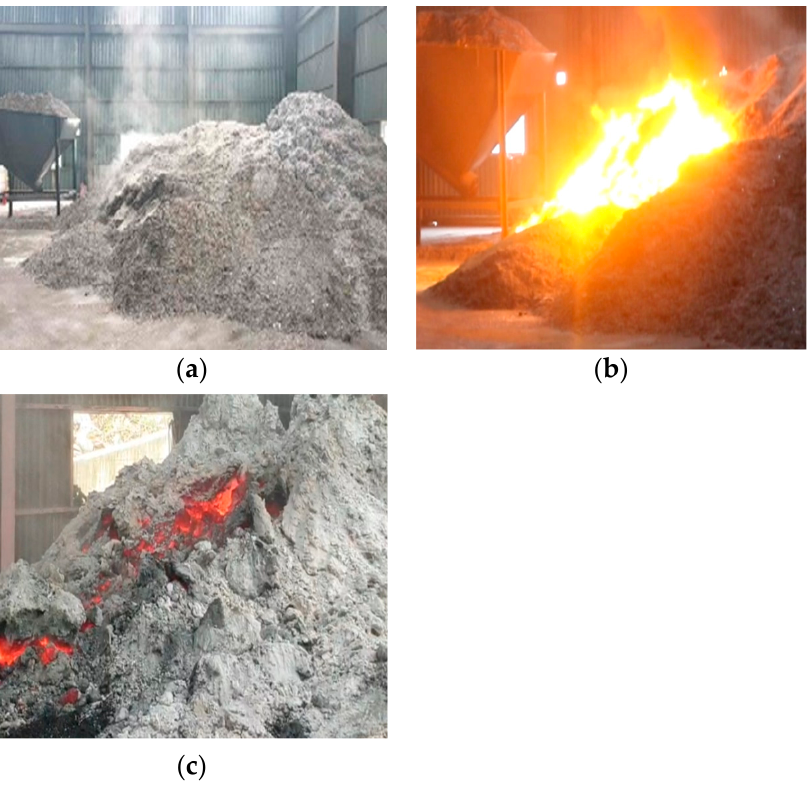
Figure 6. A combustion process of magnesium dross obtained from the Miryang accident. ( a ). Pre- smoldering with smoke. ( b ). Rapid expansion of the fire. ( c ). Post-smoldering (decline stage).